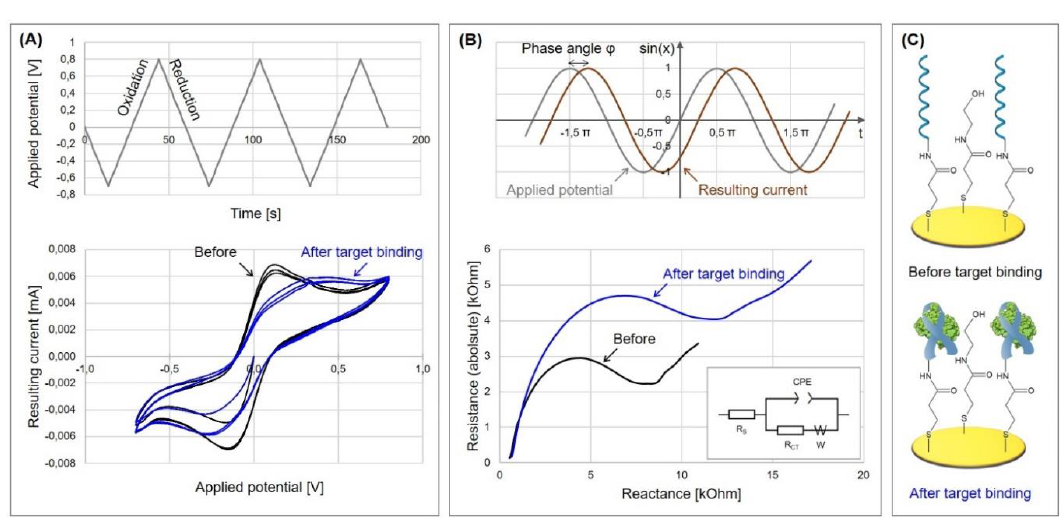
Figure 2. Characterization of target molecule binding to aptasensor via Cyclic Voltammetry (CV) and Electrochemical Impedance Spectroscopy (EIS). Experiments were performed in our laboratory (unpublished results). ( A ) Cyclic voltammogram and applied potential, potential range −0.8 V to +0.7 V with a scan rate of 50 mV/s. ( B ) Nyquist plot of impedance measurement, obtained by scanning in the range of 1 Hz–100 kHz. The inset represents the Randles equivalent circuit. The sine curves represent a general example of applied potential and resulting current in EIS. ( C ) Schematic representation of the utilized aptasensor for the detection of protein A; 3-mercaptopropionic acid was immobilized on the gold electrode, activated with 1-Ethyl-3-(3-dimethylaminopropyl)carbodiimide and N-Hydroxysuccinimide (EDC/NHS) to bind the aminated aptamer, and passivated with ethanolamine.